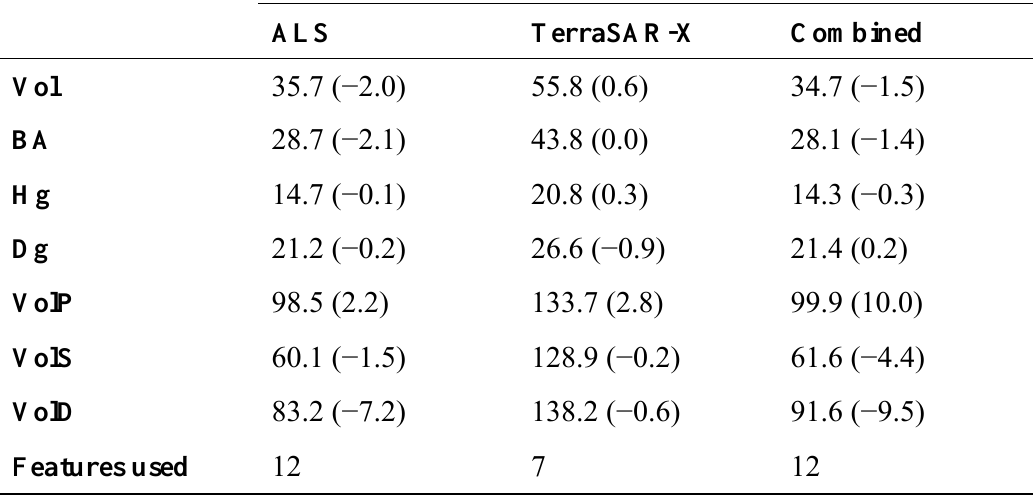
Table 3. Relative RMSEs and relative biases (in parentheses), % of means, of the estimated stand characteristics using the reduced feature